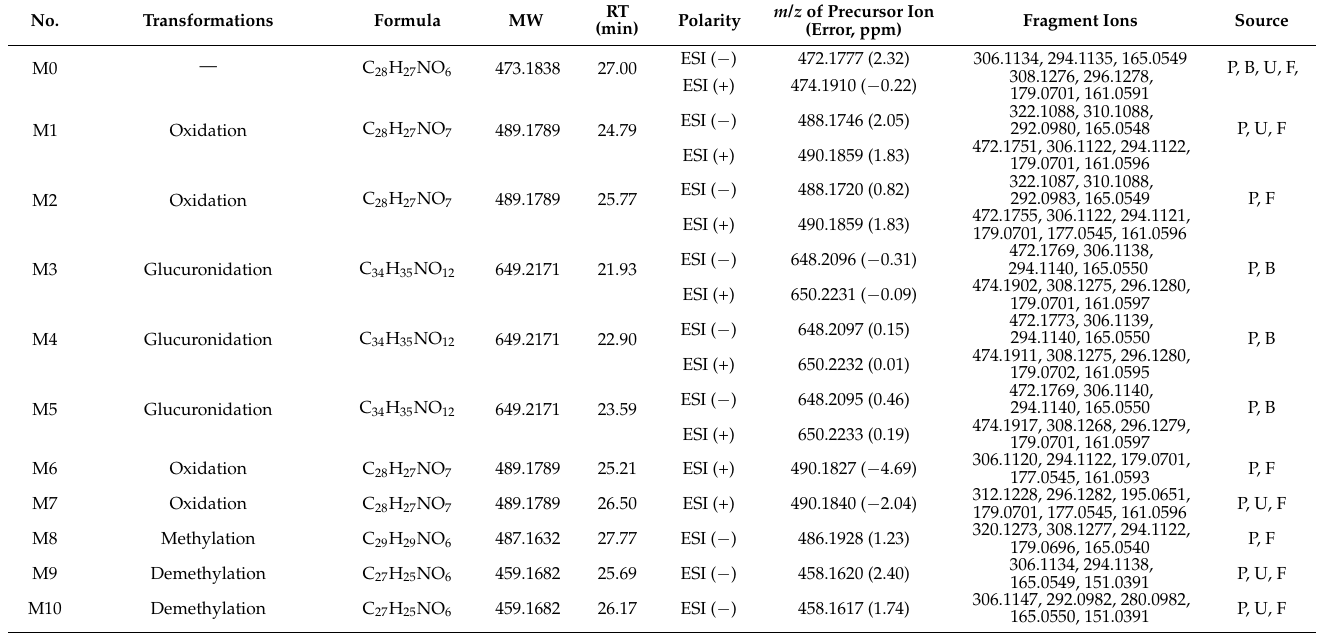
Table 1. UHPLC–HRMS-based metabolites identifications of PND in rat urine, feces, bile and